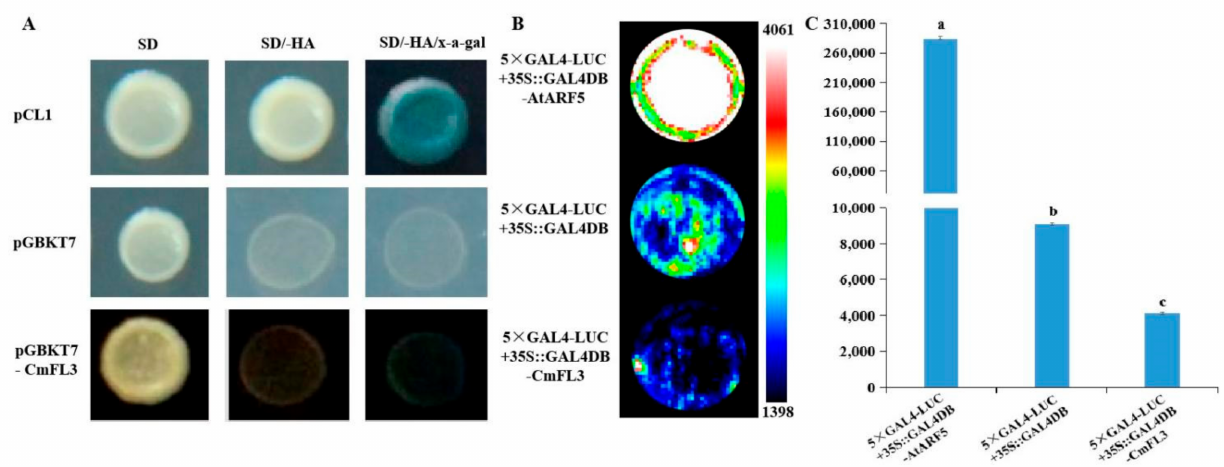
Figure 4. Transcriptional activity of CmFL3. ( A ) Transcriptional activity of CmFL3 in yeast. pCL1 and pGBKT7 are the positive and negative controls, respectively. -AH: SD/-His-Ade lacking x- α -gal; -AH+x- α -gal: SD/-His-Ade containing x- α -gal. ( B ) Arabidopsis mesophyll protoplasts captured after luciferin addition using a charge-coupled device camera. ( C ) Luciferase activity measured after the introduction of 35S::GAL4DB-CmFL3 into Arabidopsis mesophyll protoplasts. Values are represented as mean ± SE ( n = 3). Significant differences were analyzed using Duncan’s multiple range test, and bars with different letters are significantly different from each other ( p <